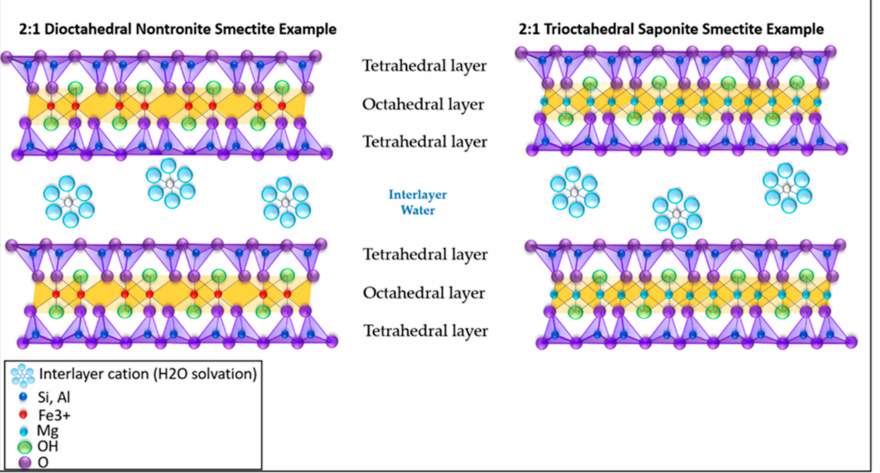
Figure 3. An example of the structure of dioctahedral nontronite and trioctahedral saponite demon- strating tetrahedral and octahedral layers (2:1), connected by hydroxyl groups and apical oxygens. In between the tetrahedral-octahedral-tetrahedral (TOT) sheets, in the interlayer site, cations are exchanged and H 2 O is adsorbed. Both of these phyllosilicates have been observed at Gale